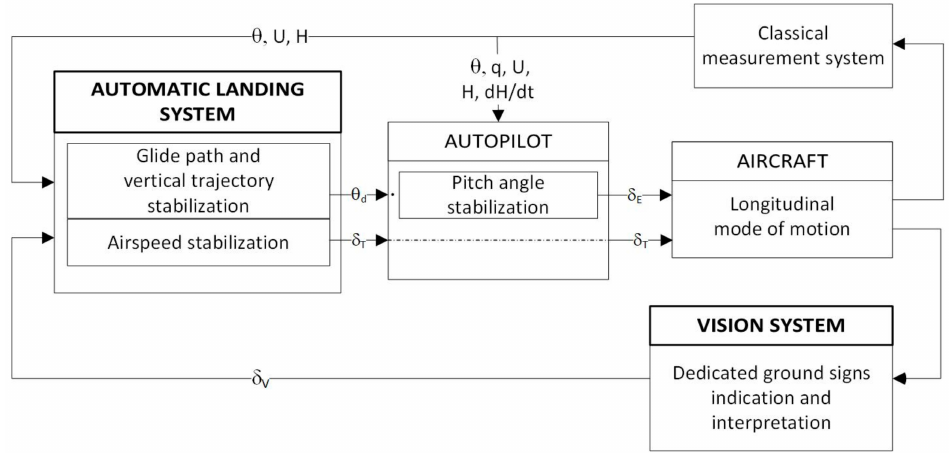
Figure 3. The functional structure of the classical autopilot control system extended with both Automatic Landing System and Vision System. θ —pitch angle; q —pitch rate; U —airspeed; dH/dt —vertical speed; H —height above the ground; θ d — desired pitch angle; δ E , δ T —control signals, elevator position and, throttle lever position respectively; δ V —vertical deviation from the desired glide path. Adapted from